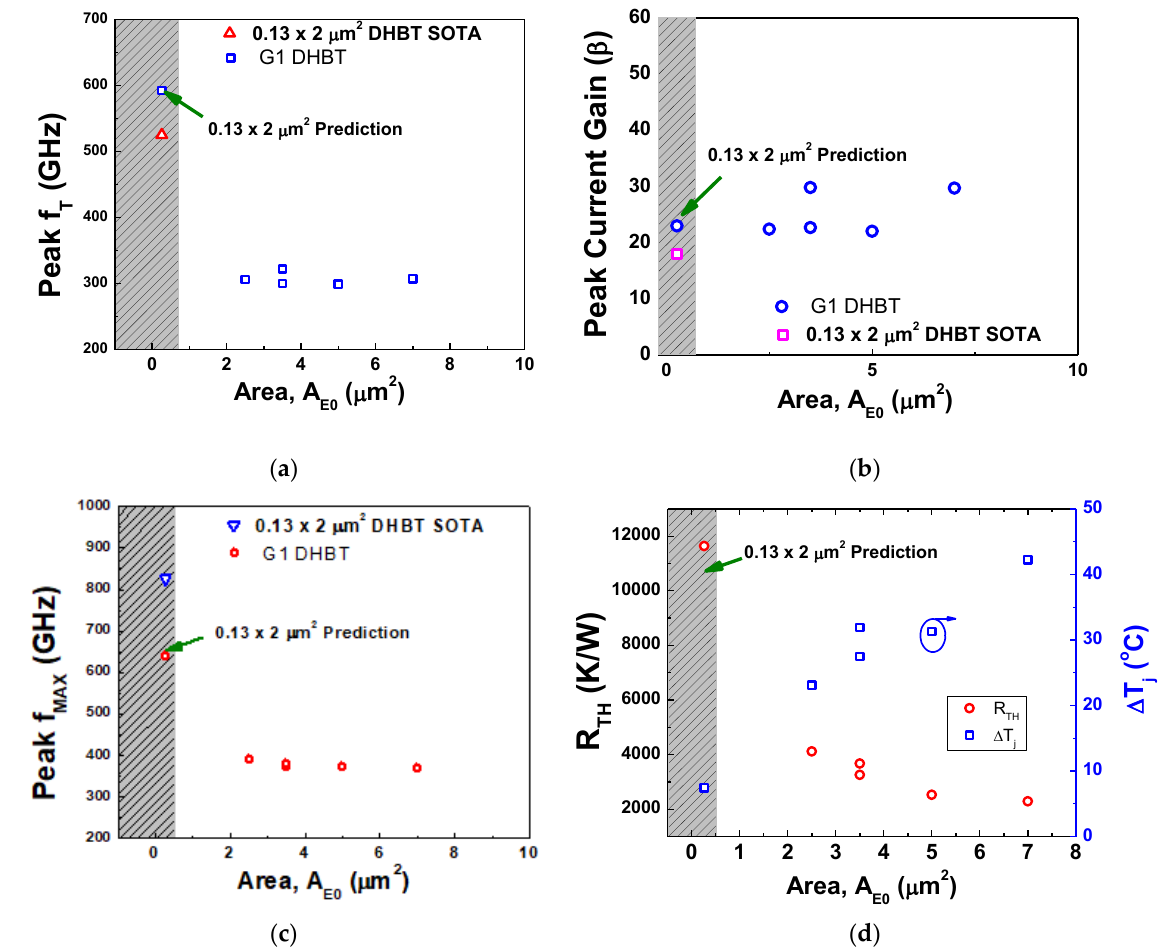
Figure 22. Extrapolating figures of merit of the III–V DHBTs: ( a ) f T ; ( b ) β ; ( c ) f MAX; and ( d ) R TH .